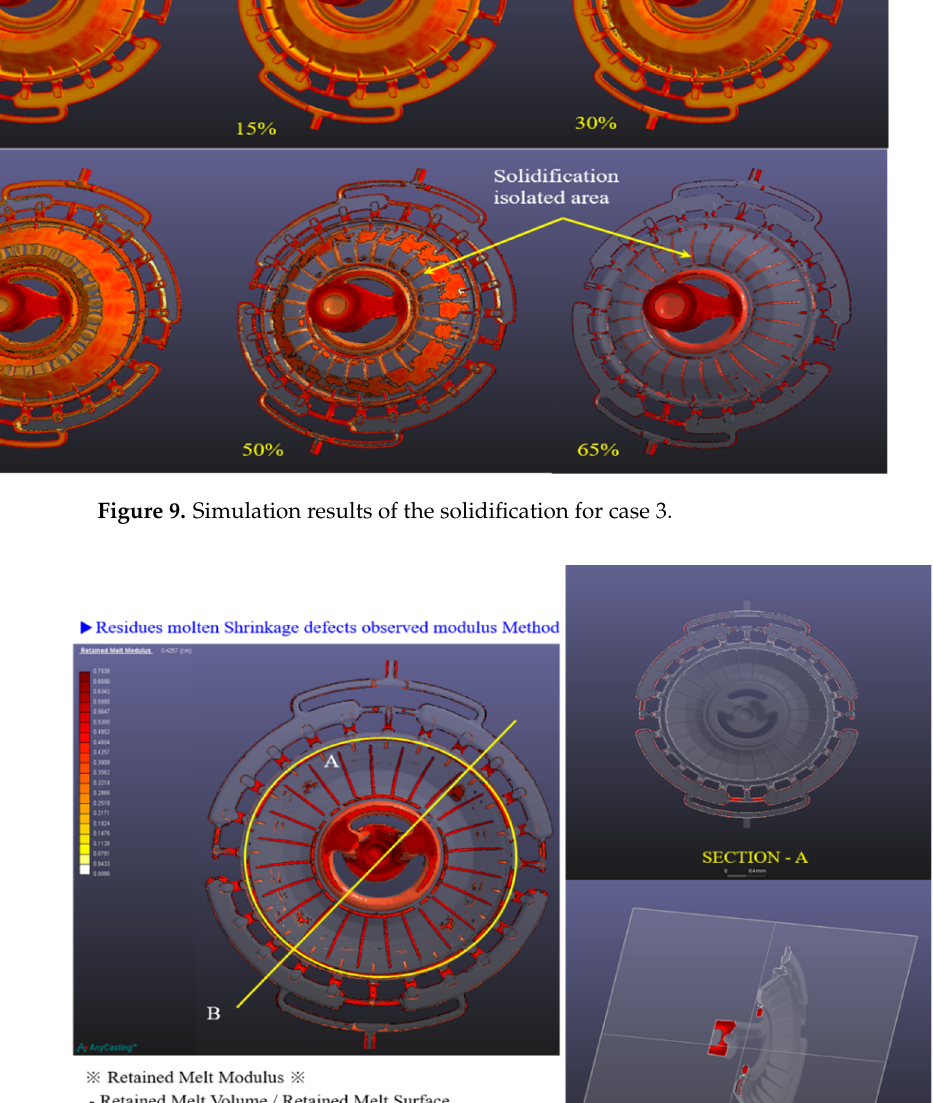
Figure 10. Expected shrinkage defect area for Case 3 at 65% solidification.